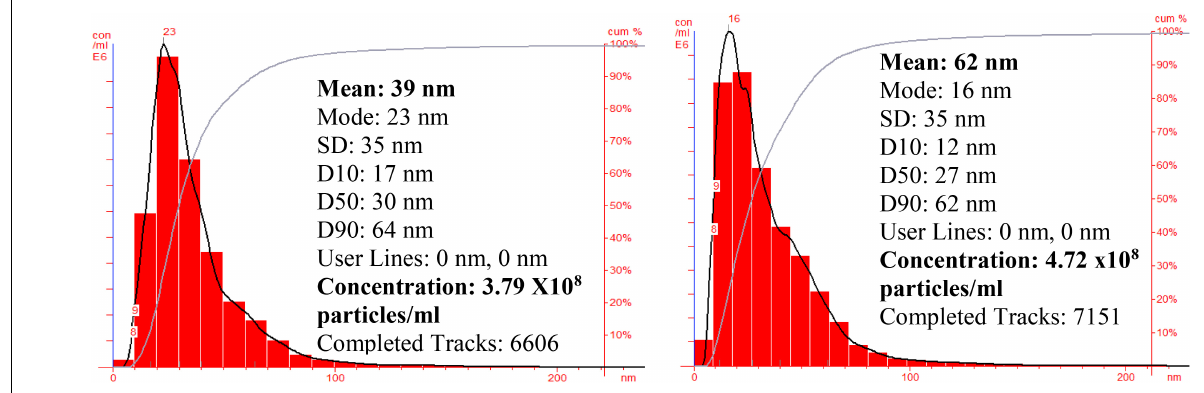
FIGURE 5 | NTA of silver and zinc nanoparticles.